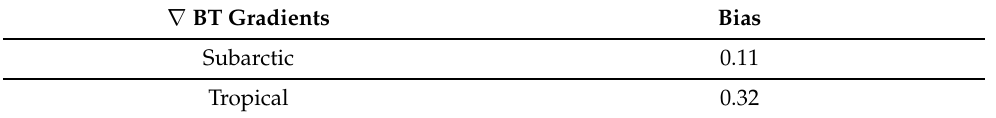
Table 2. Bias of the TOA PAN BT gradients (expressed in K/pixel) using the SST gradients as a reference. The statistics refer to the subarctic and tropical atmospheric profiles from Garand et al.